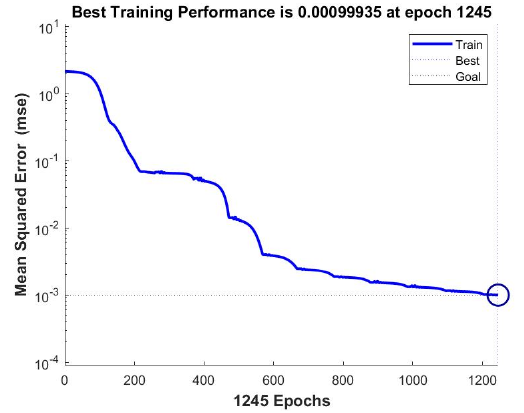
Figure 6. The training result of the back propagation (BP) neural network.